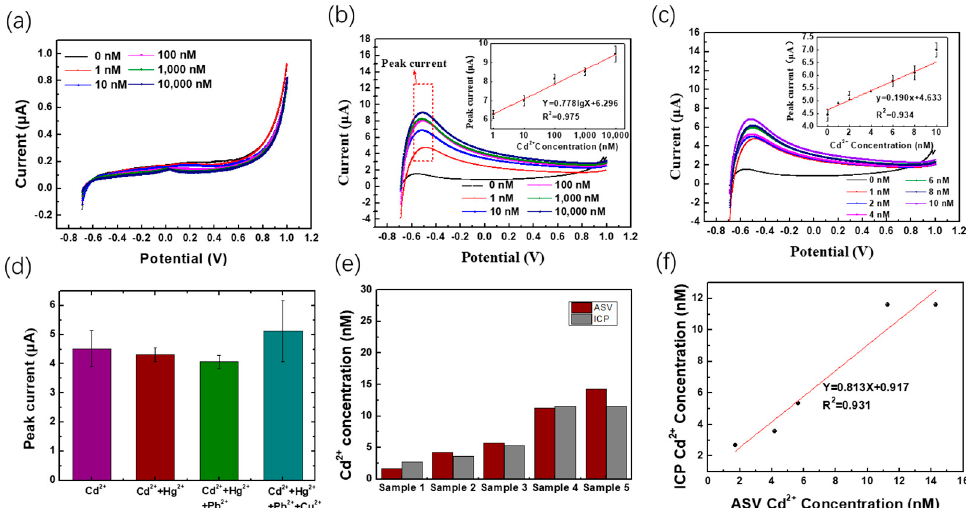
Figure 5. Electrochemical performance of the WO 3 -modified electrodes. ( a ) ASV curve of the unmodified electrodes in different concentrations of the Cd 2+ solution; ( b ) ASV curve of WO 3 -modified electrodes in high concentrations of the Cd 2+ solution (inset: linear fitting curve of the dissolution peak current of WO 3 -modified electrodes in different concentrations of the Cd 2+ solution); ( c ) ASV curve of WO 3 -modified electrodes in low concentrations of the Cd 2+ solution (inset: linear fitting curve of the dissolution peak current of WO 3 -modified electrodes in low concentrations of the Cd 2+ solution); ( d ) Comparison of the dissolution peak current of different heavy metal ions (the concentration of Cd 2+ was 1 μ M, and the other interfering ions were 25 times that of Cd 2+ ); ( e ) Comparison of ASV and ICP methods in different water samples; ( f ) Normalized fitting curve for the ASV method and the ICP method.